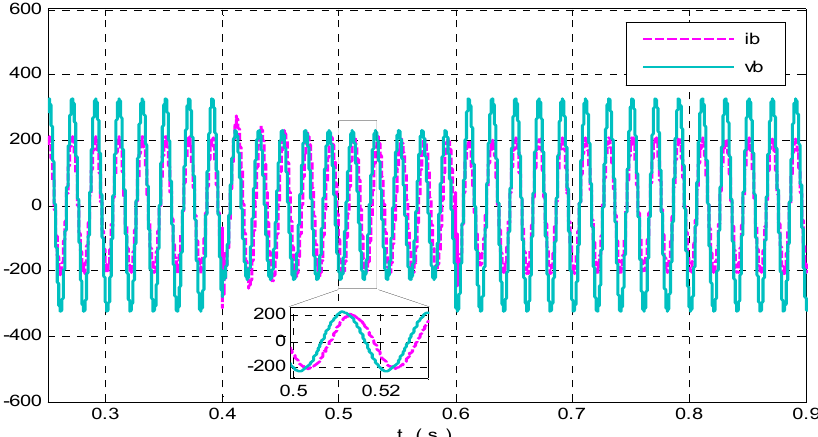
Figure 12. Voltage and current signals (phase a).